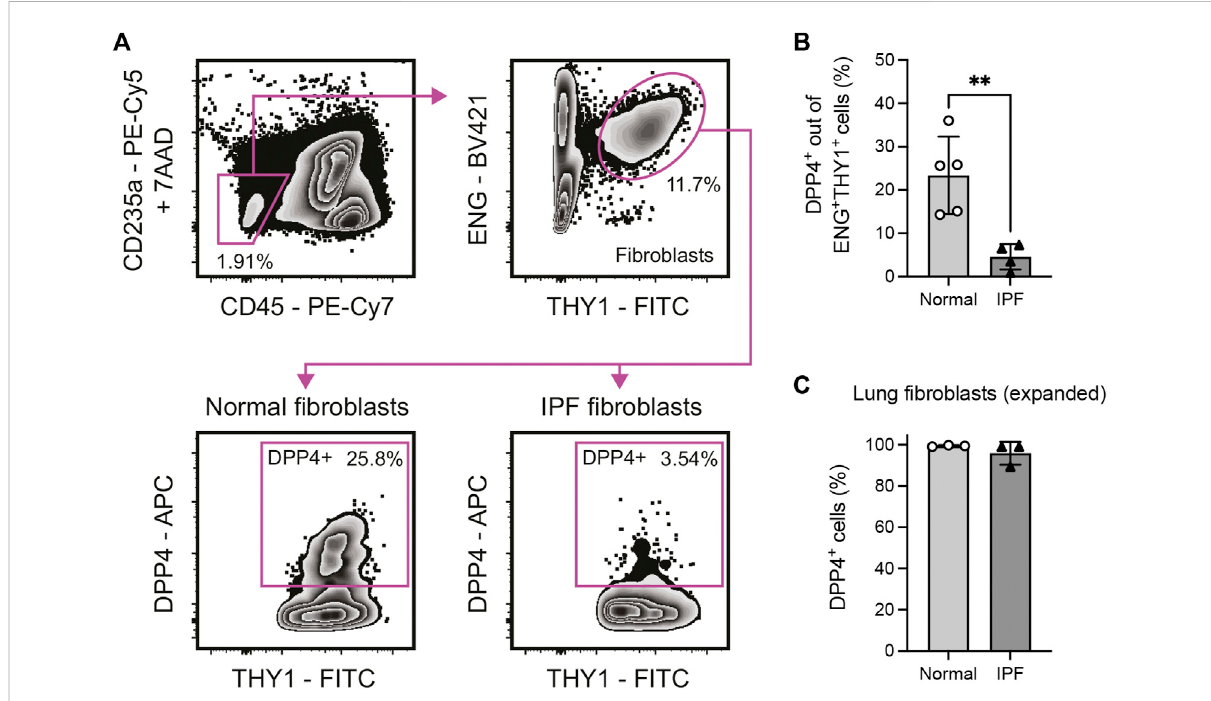
FIGURE 1 Identi fi cation of a DPP4 + fi broblast subset in normal and fi brotic (IPF) human lung tissue. (A) Flow cytometry gating of 7AAD − CD235a − CD45 − ENG + THY1 + DPP4 + lung fi broblasts inenzymatically dissociated single cell suspension from human lung tissue. (B) Percentage DPP4 + cells out of all CD235a − CD45 − ENG + THY1 + cells in normal ( n = 5) and IPF ( n = 4) lung tissue determined by fl ow cytometry analysis. (C) Percentage DPP4 + cells in fi broblast cultures (passage 7 – 8) from normal ( n = 3) and IPF ( n = 3) lung tissue, as determined by fl ow